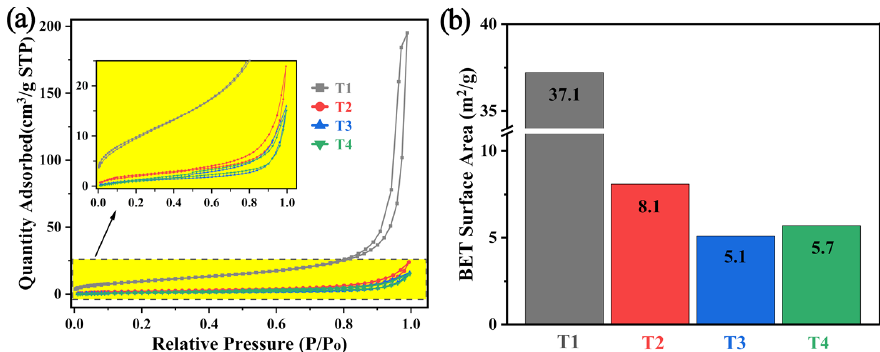
Figure 4. ( a ) N 2 adsorption–desorption isotherms of samples, ( b ) BET surface areas of samples.